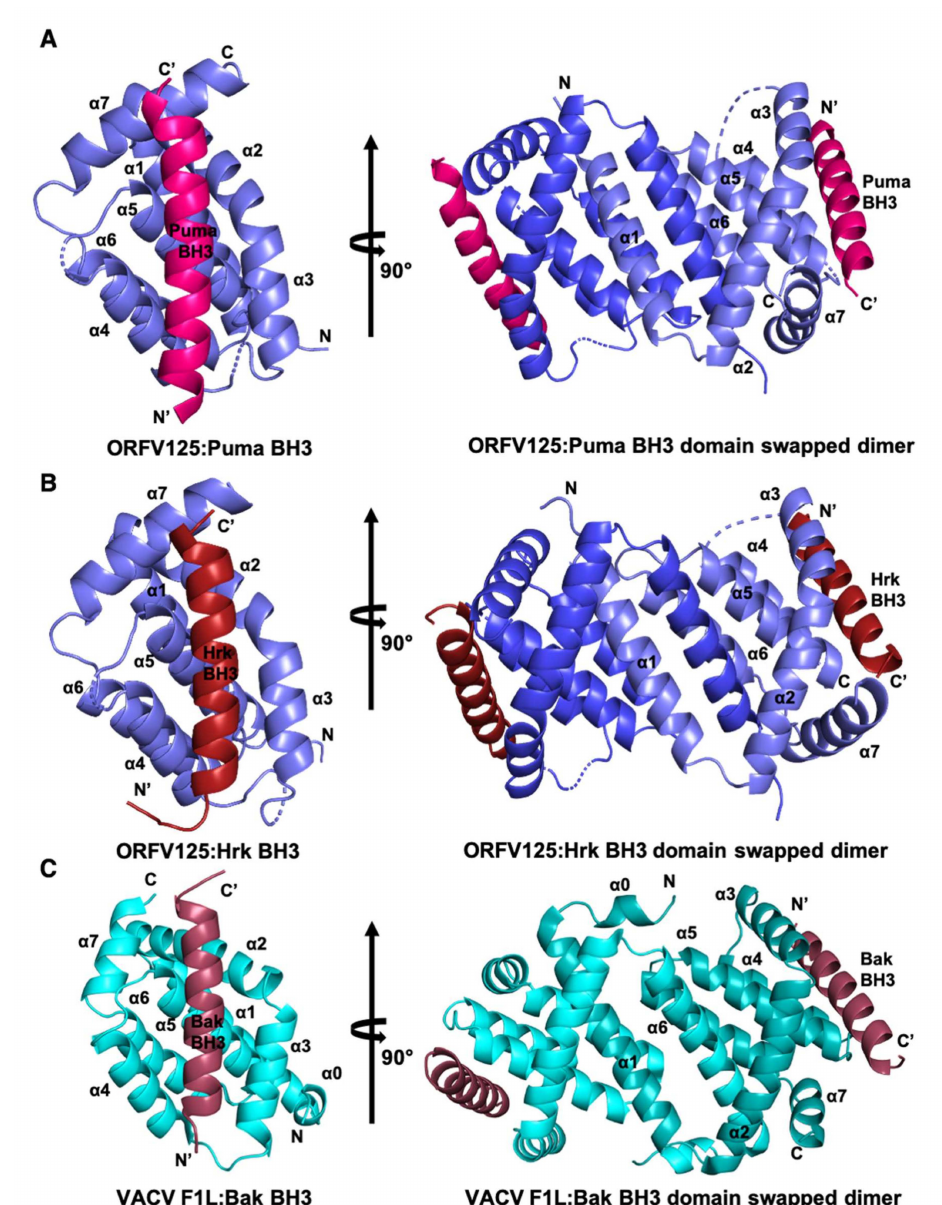
Figure 2. ORFV125 binds to BH3 motif peptides of proapoptotic Bcl-2 proteins using the canonical lig- and binding groove. Crystal structures of ORFV125 bound to Puma and Hrk BH3 motifs. ( A ) ORFV125 (slate) in complex with the Puma BH3 motif (hot pink). ORFV125 helices are labelled α 1– α 7. The left-hand view is of the hydrophobic binding groove of one protomer formed by helices α 3– α 5, and the right-hand view is the domain-swapped dimer viewed along the two-fold symmetry axis between the domain-swapped α 1 helices. ( B ) ORFV125 (slate) in complex with the Hrk BH3 domain (brick red) ( C ) VACV F1L (cyan) in complex with the Bak BH3 domain (raspberry). Images were generated using the PYMOL Molecular Graphics System, Version 1.8 Schrödinger, LLC. 6. The N- and C-termini are indicated as N and C for the Bcl-2 protein and N’ and C’ for the BH3 peptide,